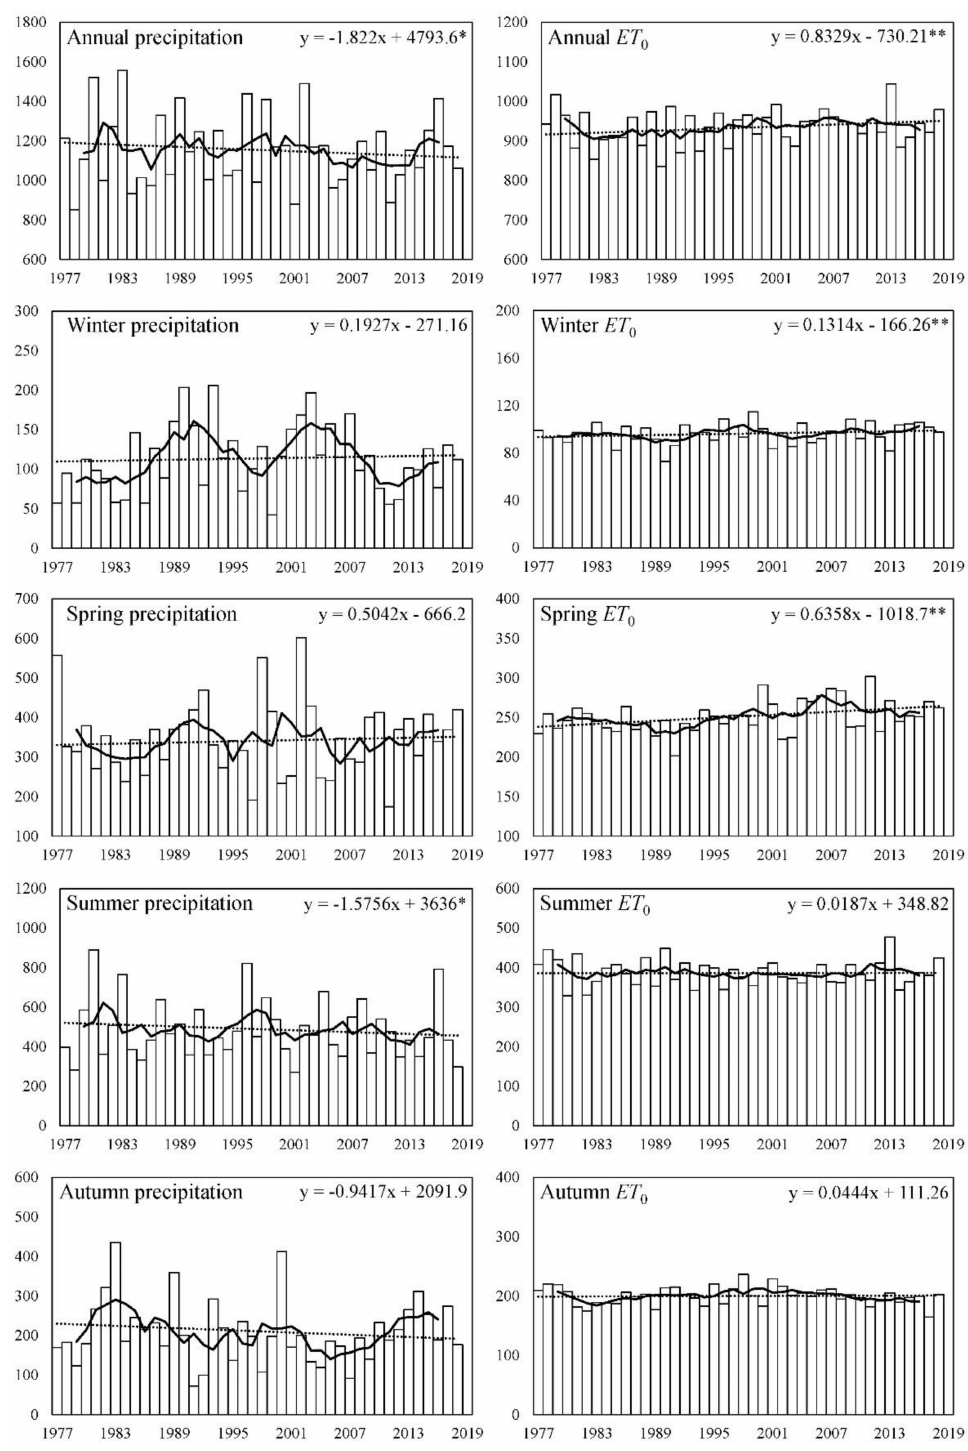
Figure A4. The temporal trends of the annual and seasonal precipitation and ET 0 in JHP for the period from 1977 to 2018. The formulations of the trends are located at the top right corners of the frames. * (**) Statistically significant change at the 0.05 (0.01)